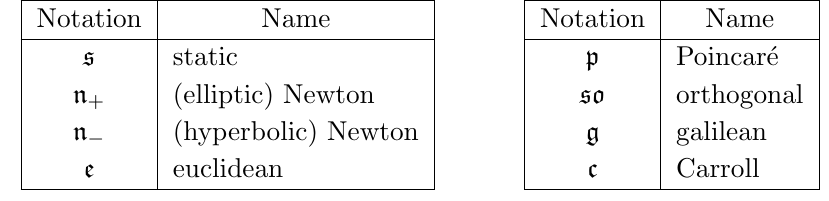
Table 3 . Notation for Lie algebras.